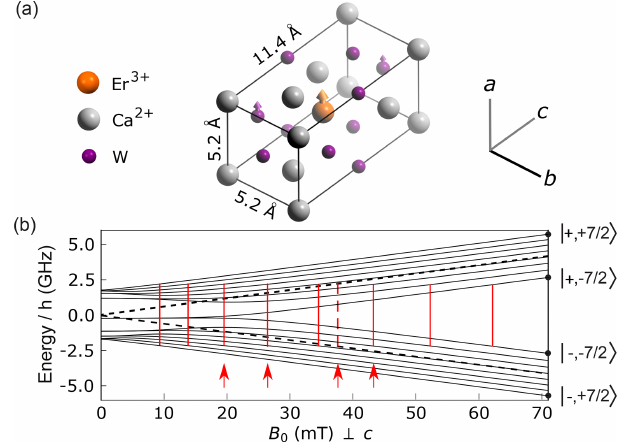
Figure 3. Structure and energy diagram of erbium ions in CaWO 4 . (a) Crystal structure with oxygen atoms hidden for clarity. Erbium atoms are in substitution of the calcium. The crystal has a rota- tional symmetry around the c axis. A fraction p = 0 . 13 of the W atoms are of the 183 W isotope, with a nuclear spin of 1 / 2. (b) En- ergy level diagram of the I = 0 erbium isotopes (dashed black line) and of the 167 Er isotope (solid black lines) with I = 7 / 2 for B 0 ap- plied perpendicular to the c axis. Vertical red lines indicate the value of B 0 for which an allowed EPR transition becomes resonant with the 4 . 372GHz frequency of our detection resonator (see main text, Sect. 4). Four red arrows indicate the values of B 0 at which ESEEM data were